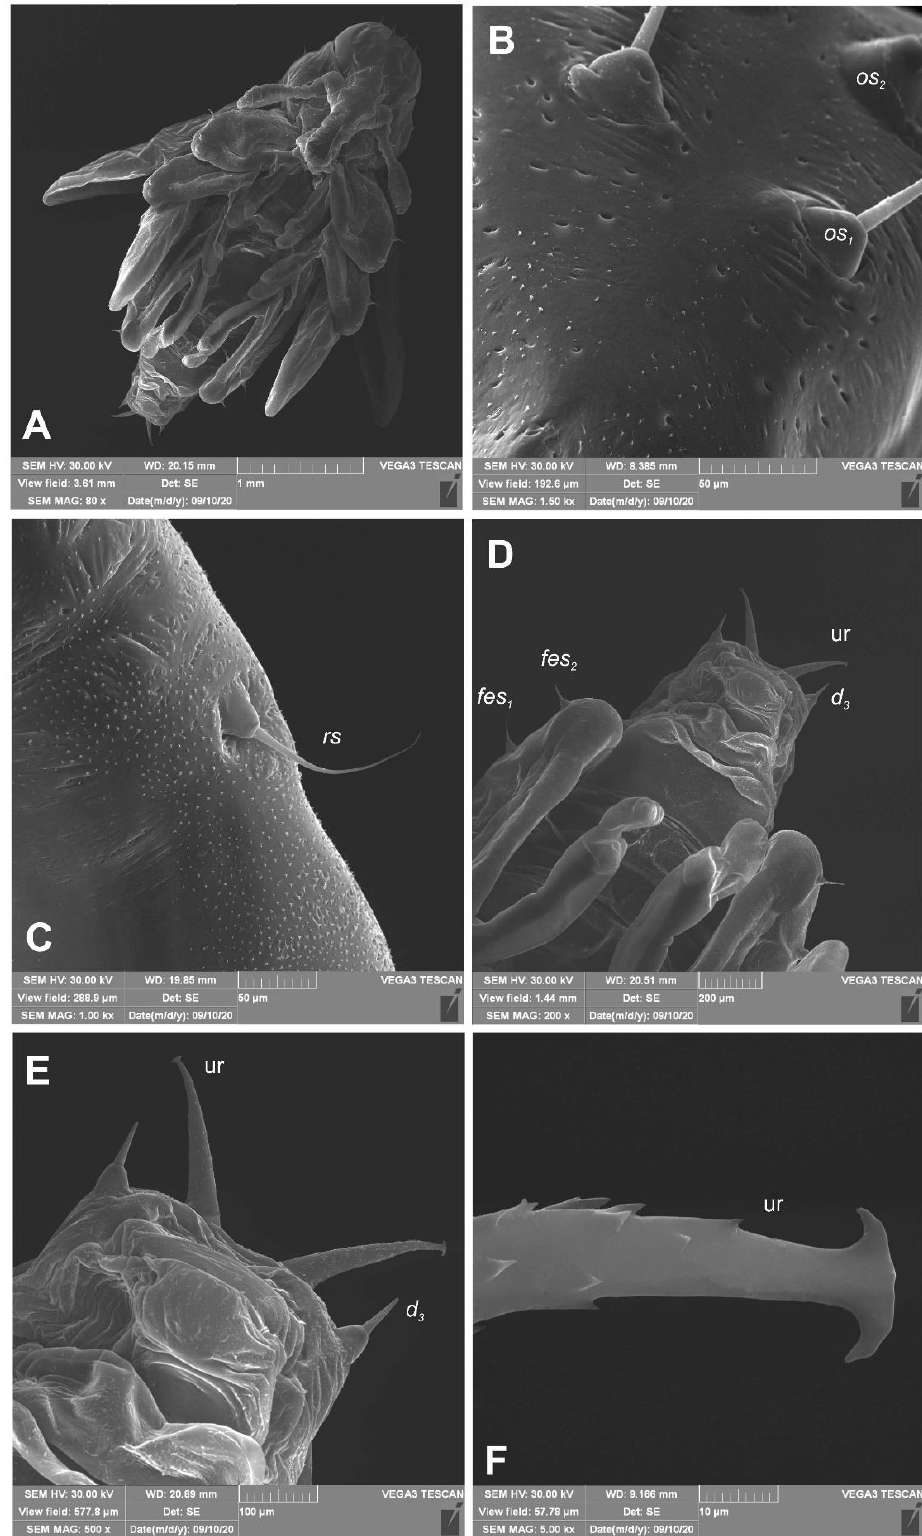
Figure 12. Euryommatus mariae pupa (SEM micrographs). ( A ) Habitus, ventral view; ( B ) head, frontal view, apical part; ( C ) rostrum base, lateral view; ( D ) abdomen, ventral view, magnification; ( E ) gonothecae; ( F ) urogomphus (ur—urogomphus, setae: d —dorsal, fes —femoral, os —orbital, rs —rostral).